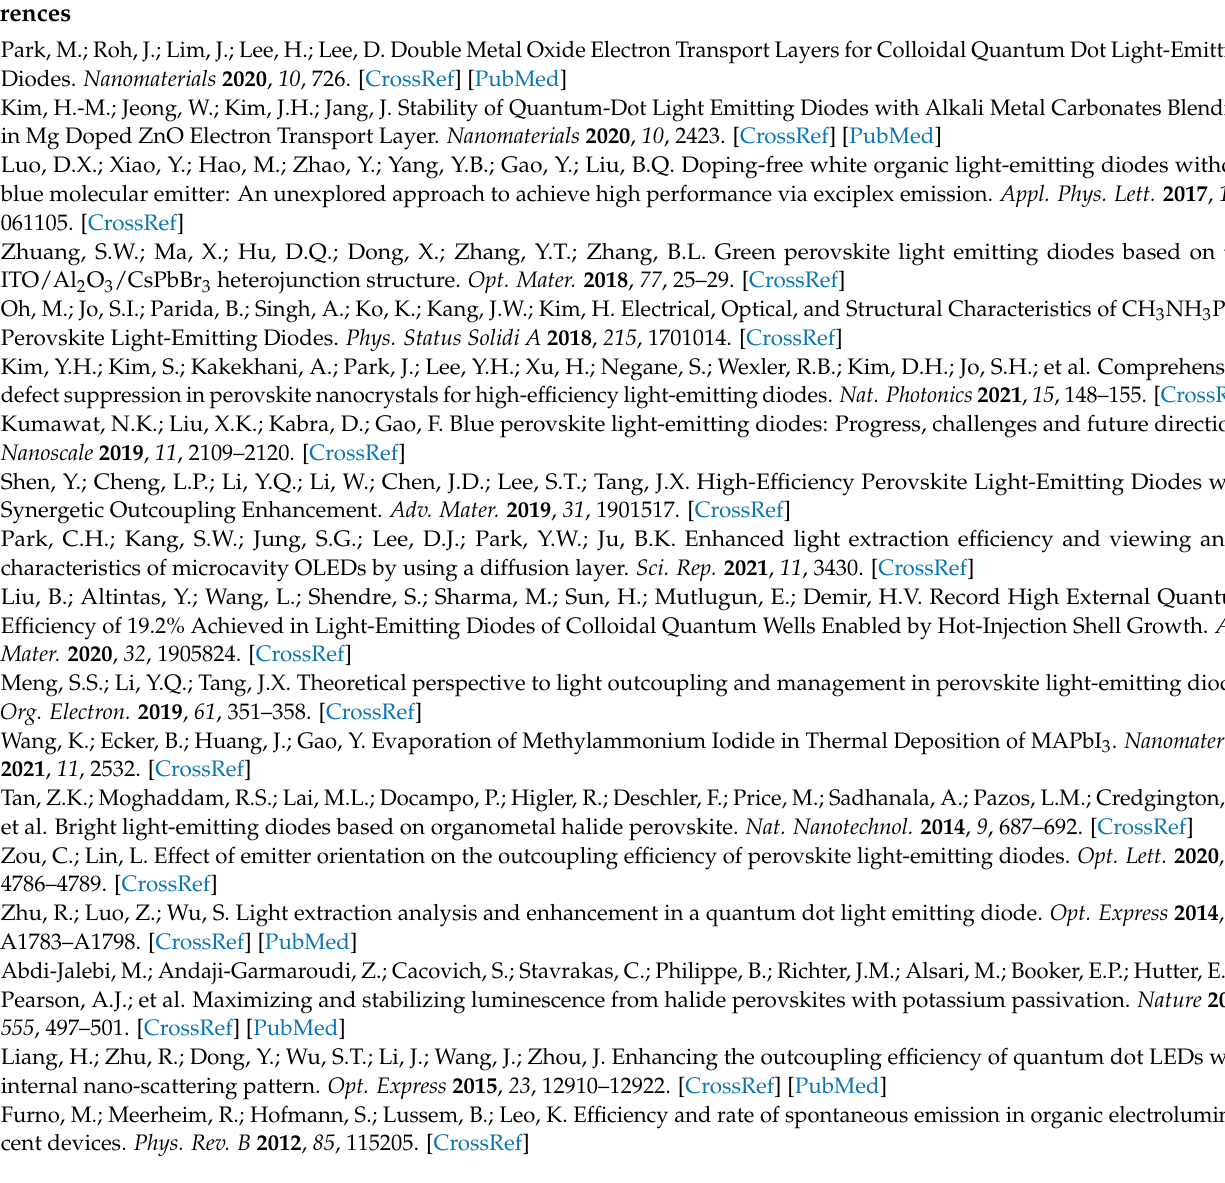
dipole orientation, Figure S3: Effect of perovskite thickness, Figure S4: All horizontal